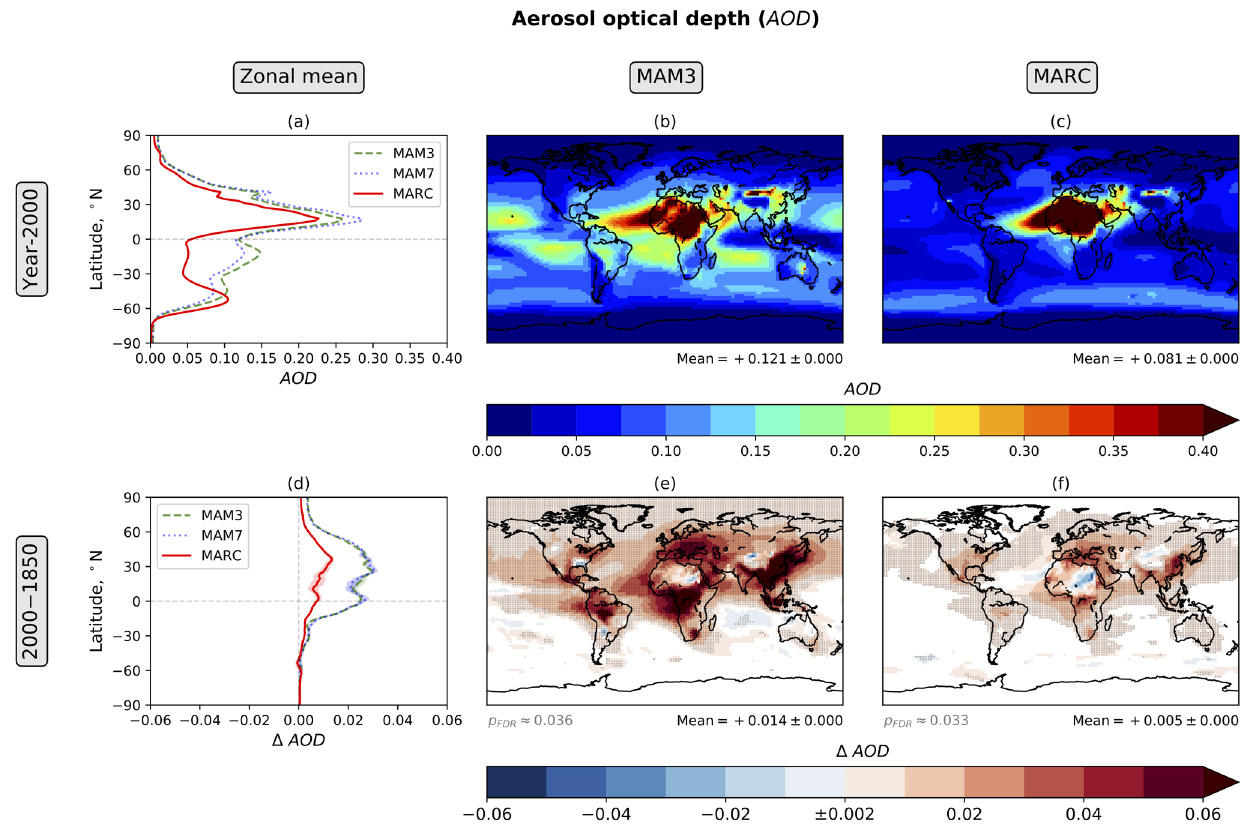
Figure 7. Annual mean aerosol optical depth (AOD). The figure components are explained in the Fig. 2 caption.